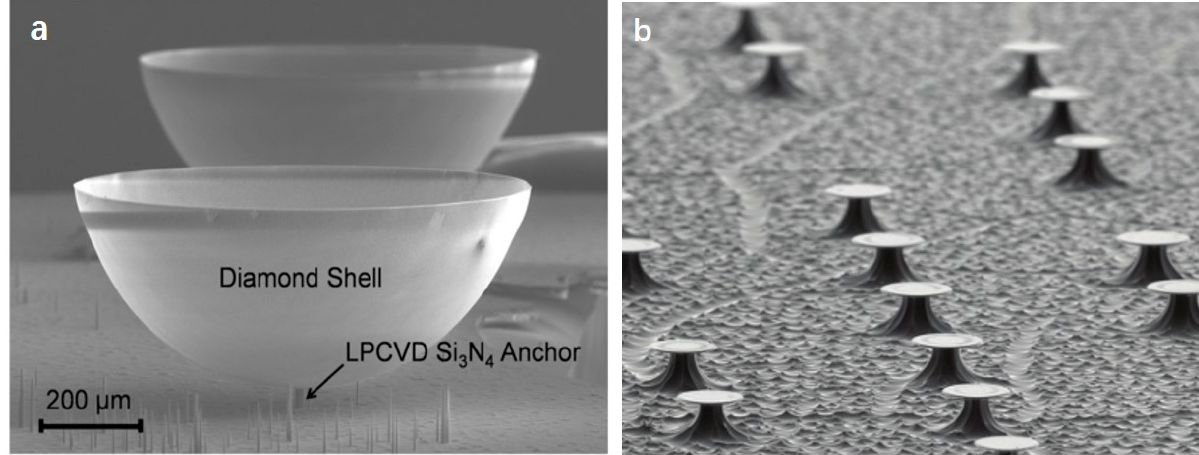
Figure 7. Hemispherical shell resonator and microdisk resonator made of diamond material. ( a ) SEM image of diamond shell resonator with Si 3 N 4 as anchor. Adapted with permission from [93]. ( b ) SEM images of inkjet-printed diamond micro-resonators. Adapted with permission from [24].